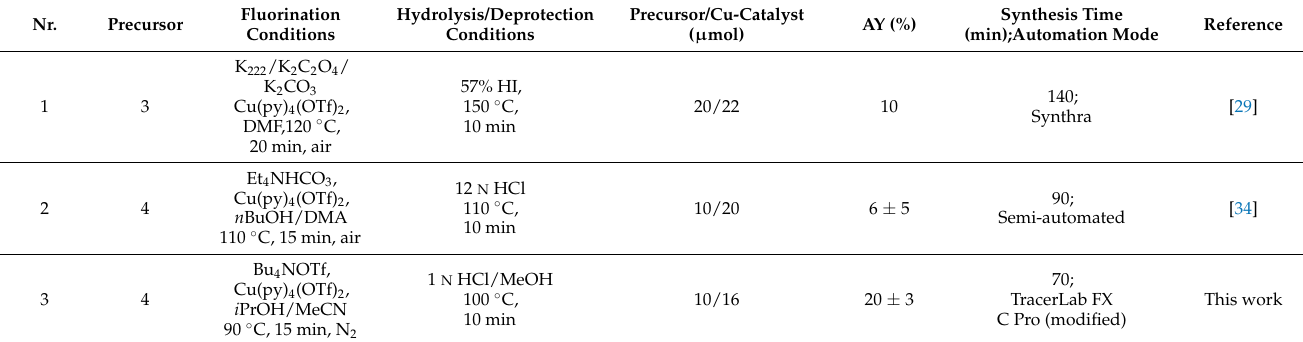
Table 1. Automated production of 6- L -[ 18 F]FMT by Cu-mediated radiofluorination of ArylBPin precursors.